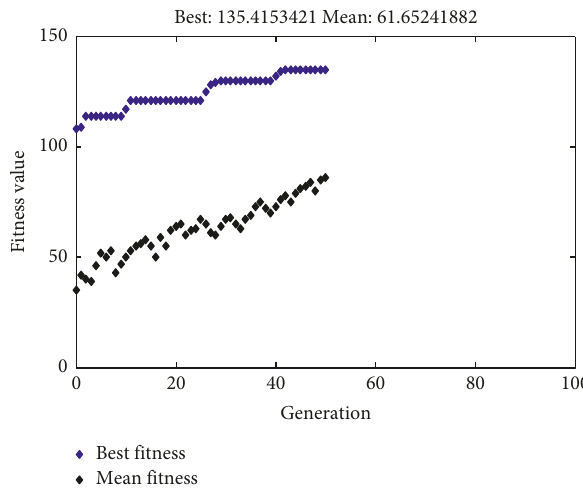
Figure 6: Import of goal function and